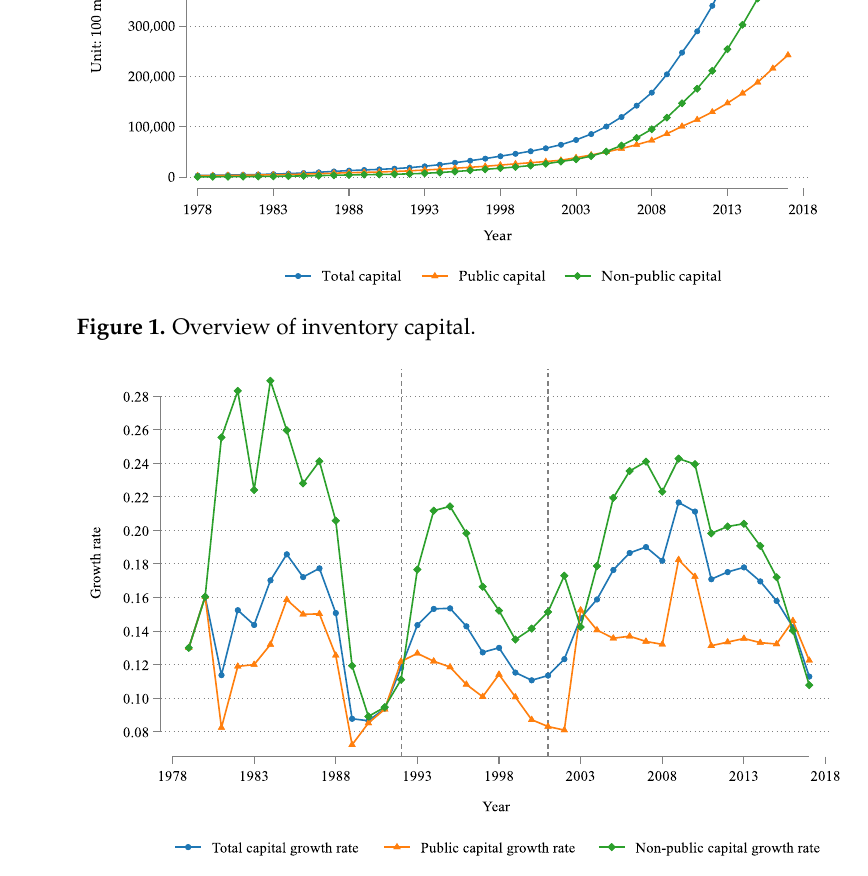
Figure 2. Capital growth rate.